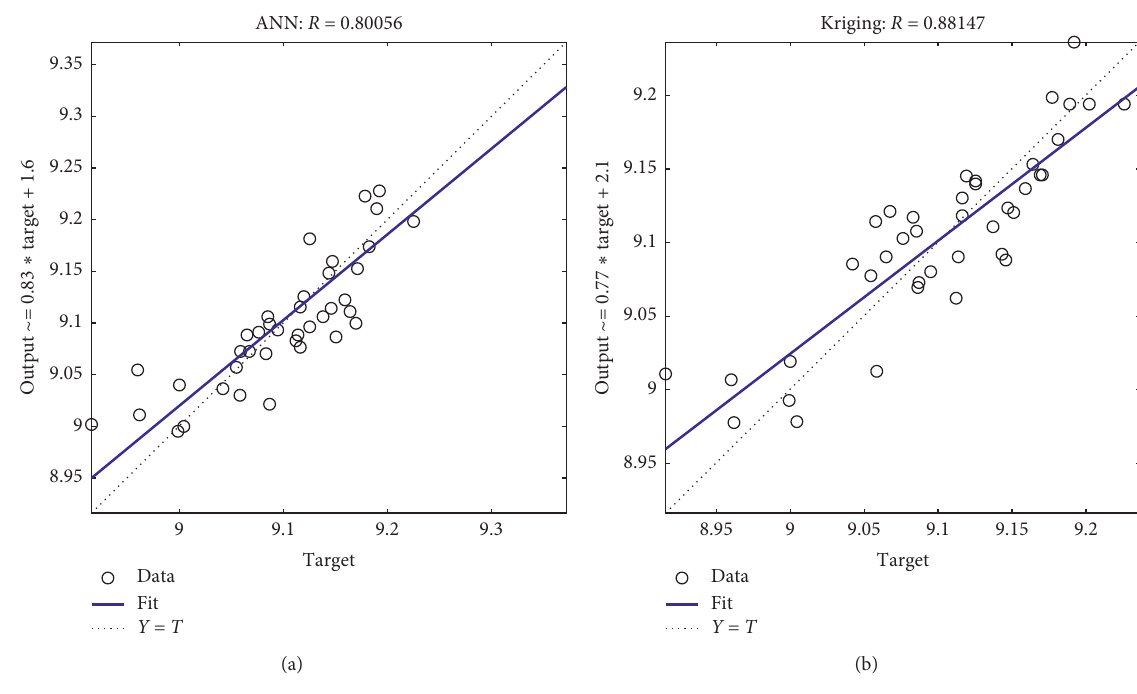
Figure 13: R -square analysis.